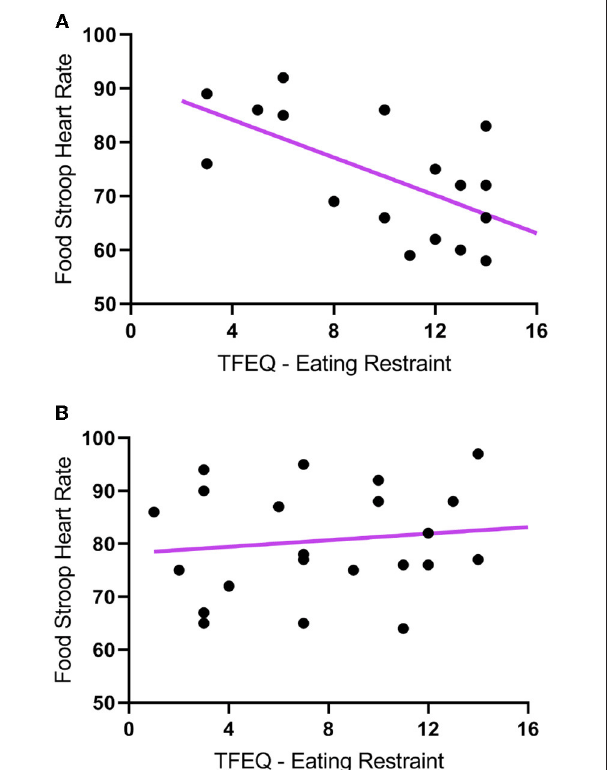
FIGURE 1 | The correlations between Eating Restraint scores (Three Factor Eating Questionnaire) and heart rates recorded during the Food Stroop tasks. (A) clinically relevant weight loss (CWL; ≥ 5% of body mass) group ( r = 0.62, p < 0.01) and (B) women who had never weight cycled (CTL).